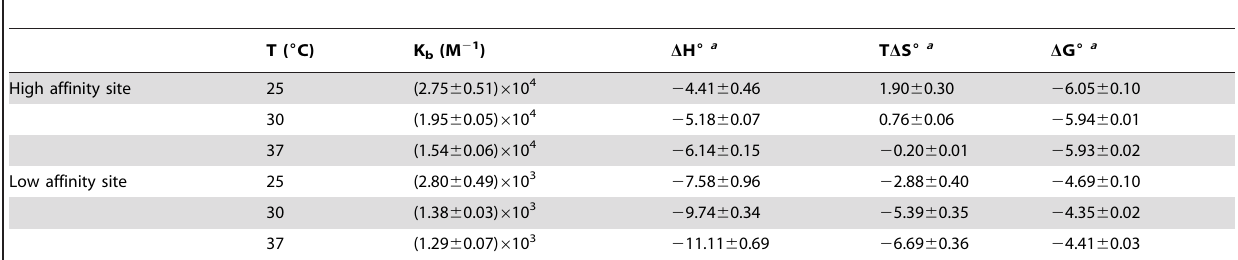
Table 2. Thermodynamic parameters and association constant of HSA-HA obtained by isothermal titration calorimetry.